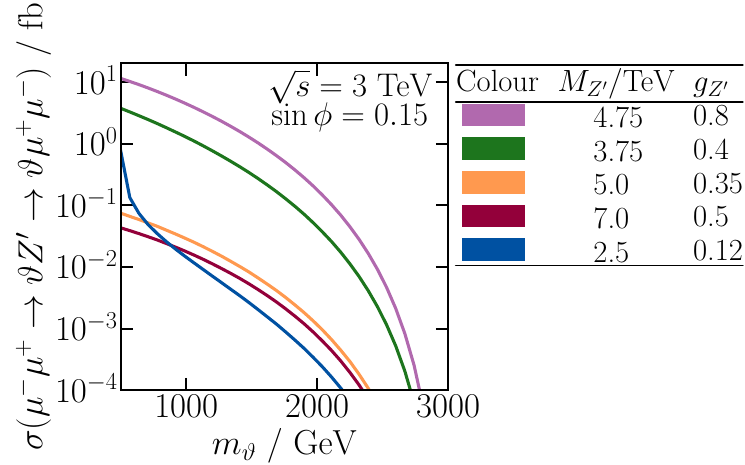
Figure 13. Tree-level flavonstrahlung cross-sections for 3 TeV µ + µ − collisions for q θ = 1 . Each coloured line corresponds to a parameter point labelled by a star of the same colour in figure 10. The cross-sections do not include ISR effects.